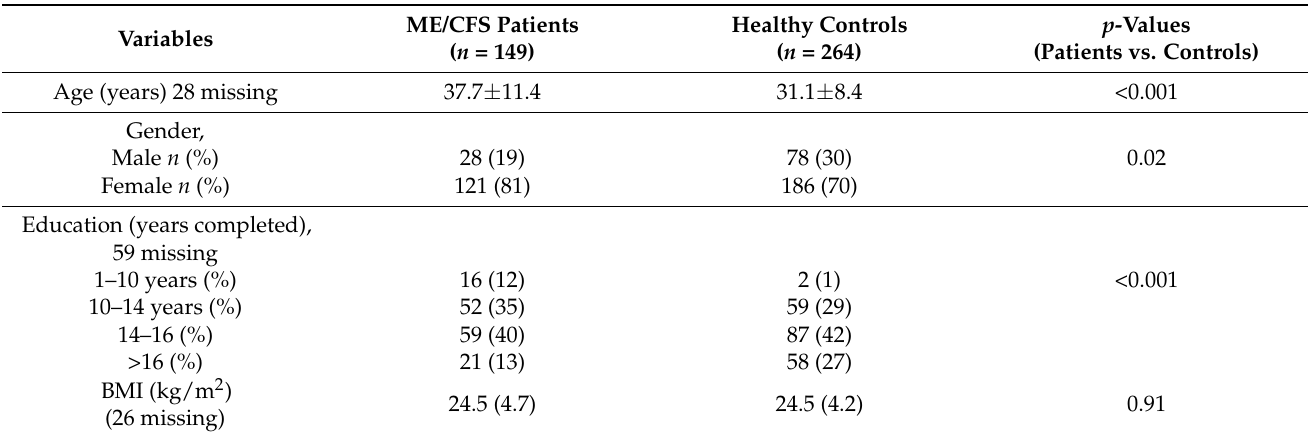
Table 1. Mean ± standard deviation, and T-tests conducted on demographic and clinical characteristics for ME/CFS patients and healthy